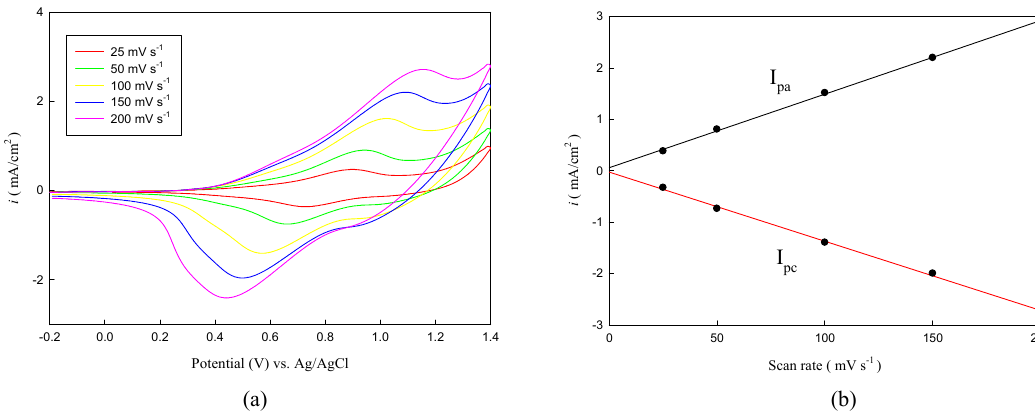
Figure 3. ( a ) CV curves of the P(TTPA- co -DIT) film at various scan rates between 25 and 200 mV·s − 1 in 0.1 M LiClO 4 /ACN solution. P(TTPA- co -DIT) film was prepared potentiostatically at 1.0 V; ( b ) Relation between peak current density and scan rate of the P(TTPA- co -DIT) film in 0.1 M LiClO 4 /ACN solution.